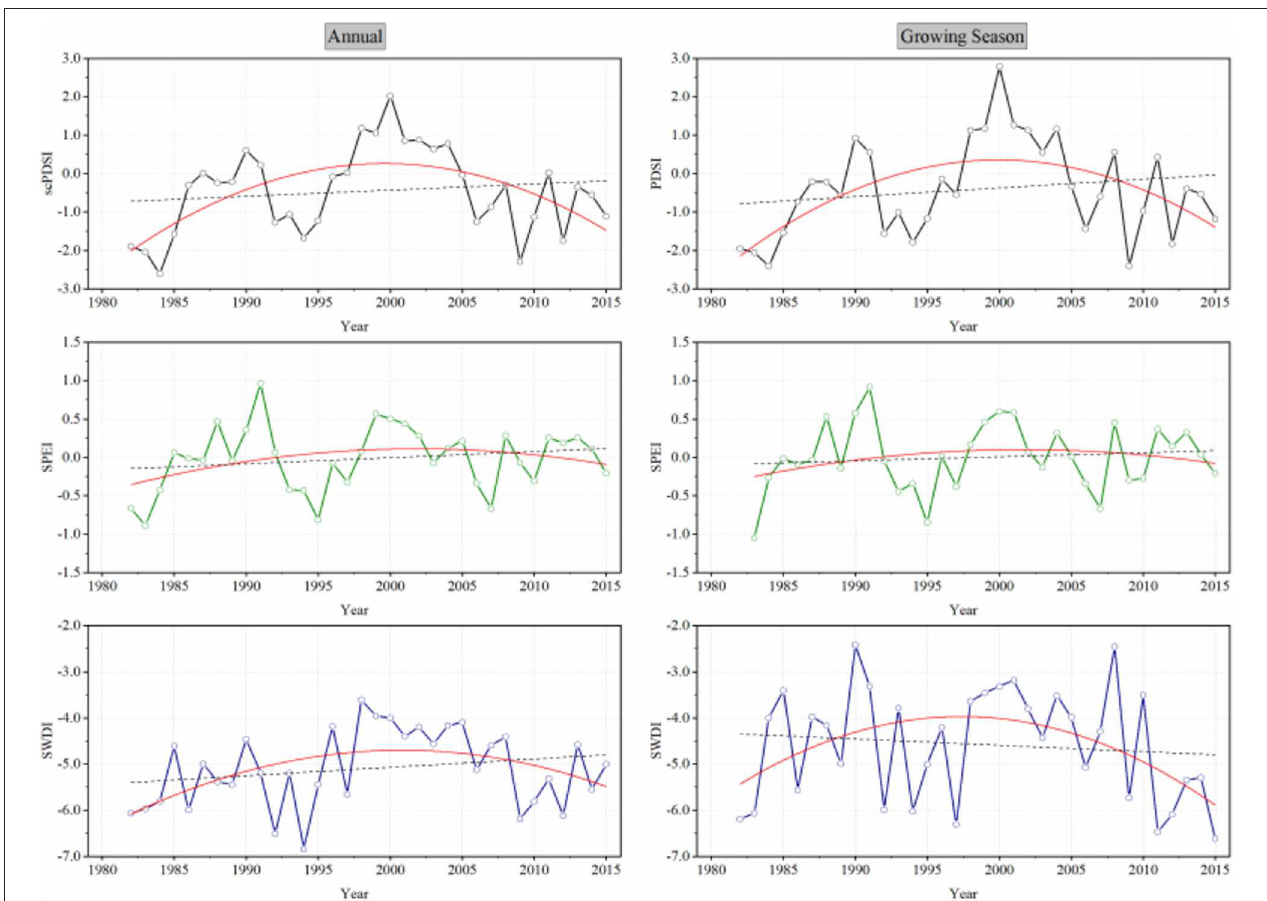
FIGURE 2 | Variation trend of three drought indices (the black, green, and blue curves are scPDSI, SPEI, and SWDI, respectively. The red solid lines are curves fitted by quadratic polynomial. The black dashed lines are linear trend lines from 1982 to 2015. And the left column is annual variations of three indices, while the left column is variations of growing